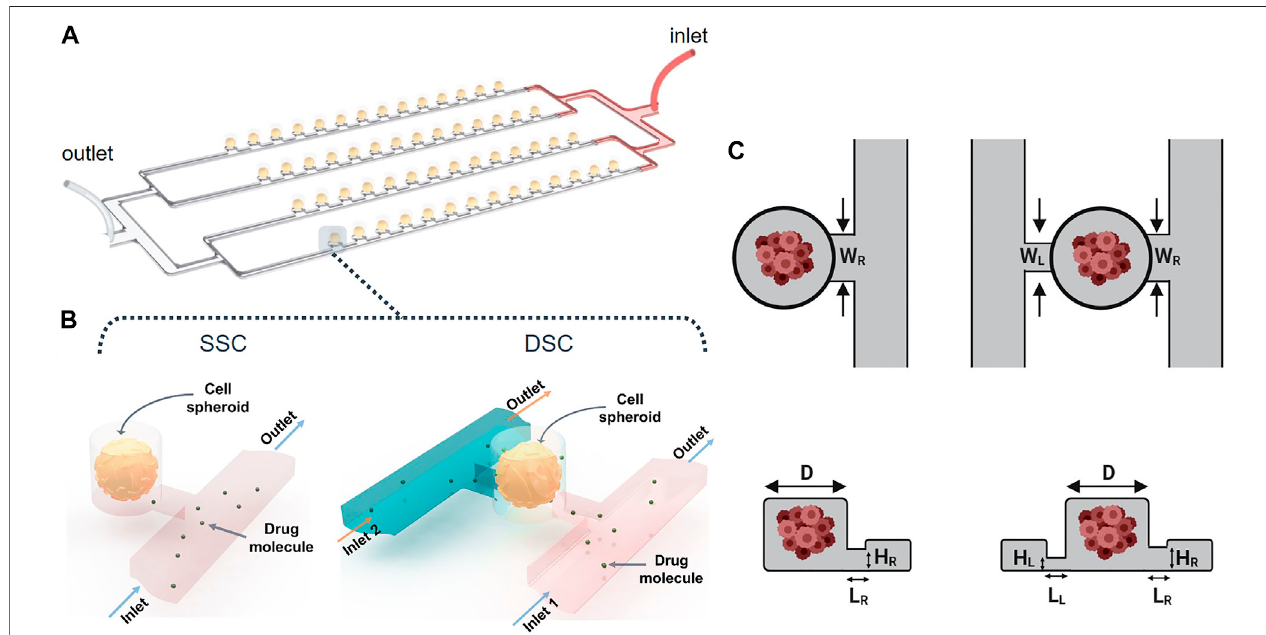
FIGURE 2 | Spheroid-on-a-chip device design and geometry. (A) 3D illustration of the array-based spheroid-on-chip micro fl uidic device used in this study. (B) Illustration of single supply channel (SSC) and double supply channel (DSC) designs of the spheroid-on-a-chip device. (C,D) Geometric parameters considered in the design optimization of the SSC and DSC spheroid-on-a-chip designs.